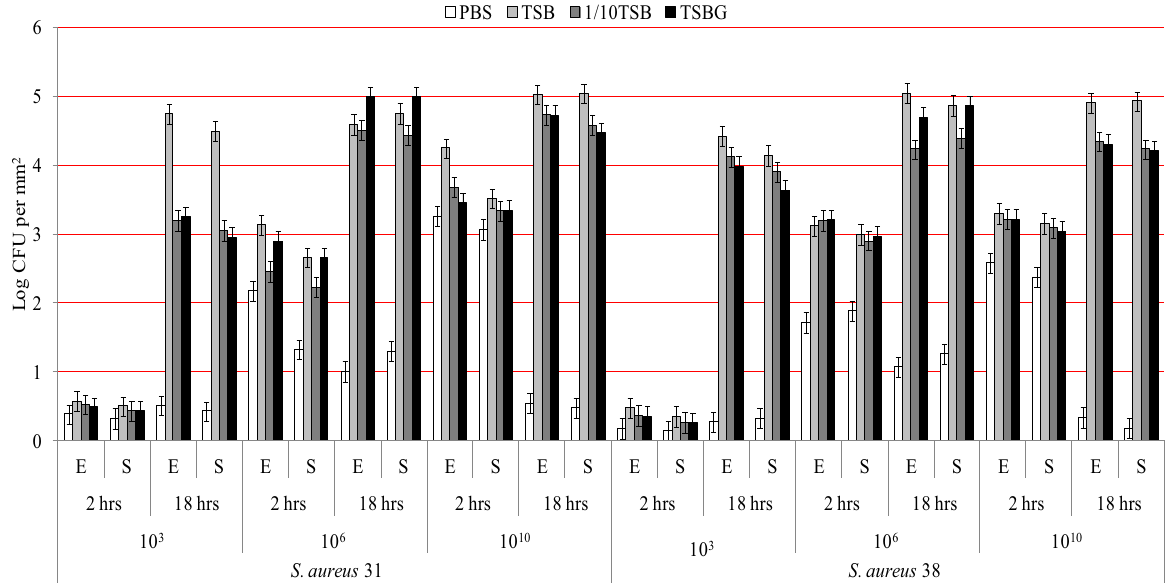
Figure 2. Adhesion of S . aureus to contact lenses under different conditions.